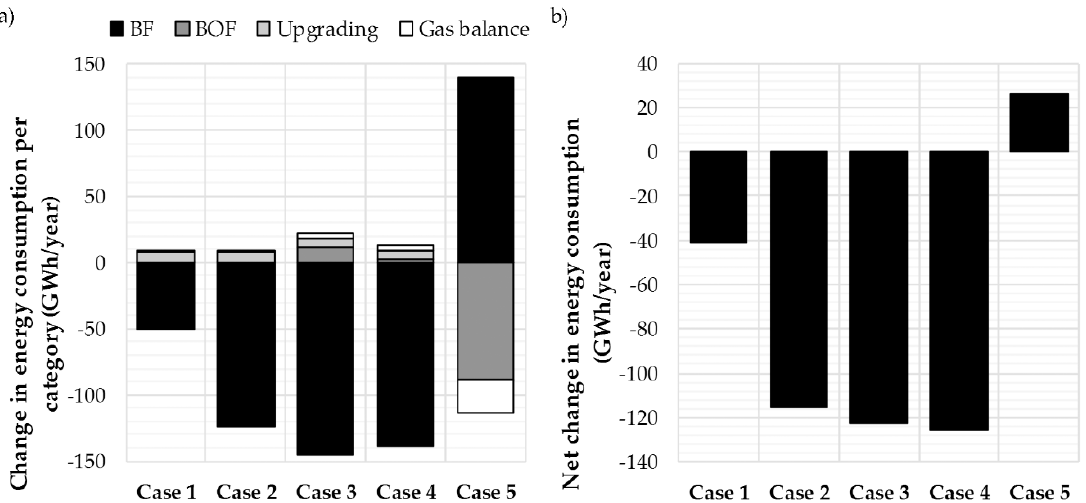
Figure 3. Results of the process integration analyses: ( a ) Change in energy used in each process; ( b ) net change in energy consumption.